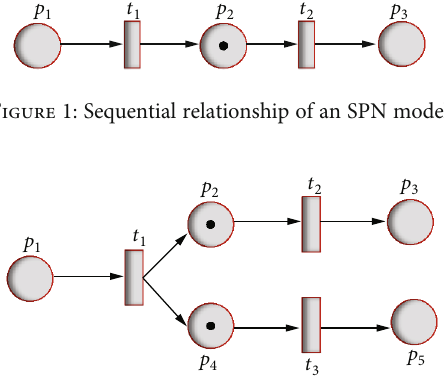
Figure 2: Concurrency relationship of an SPN model.